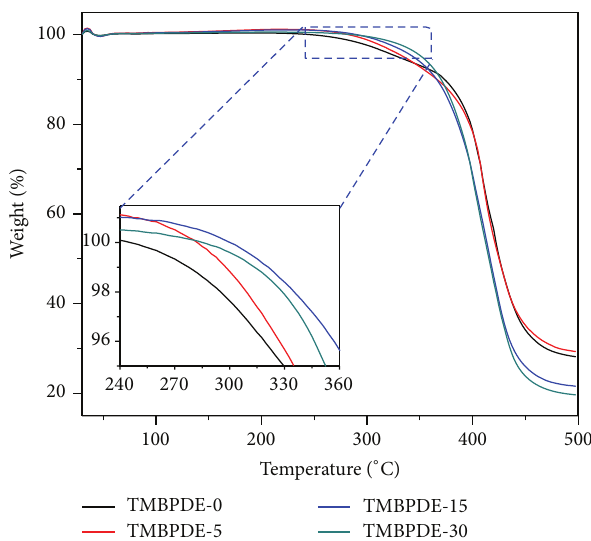
Figure8:ThermogravimetricanalysisofUFUR/TMBPDEcompos- ite resins with different TMBPDE contents.